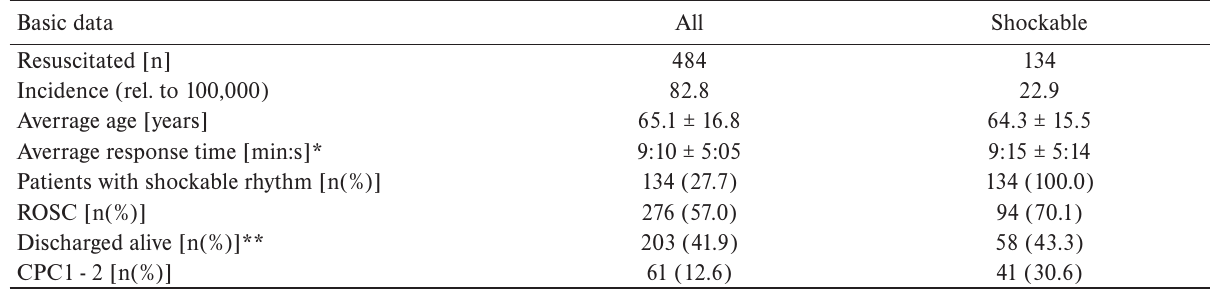
Table 2. Comparison of all rhythms and shockable rhythm